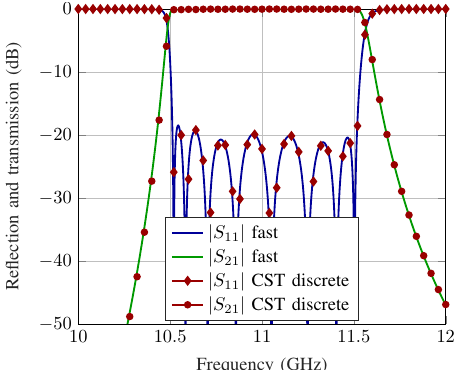
Figure 15. Comparison of fast and discrete sweep for the eight-pole SIW